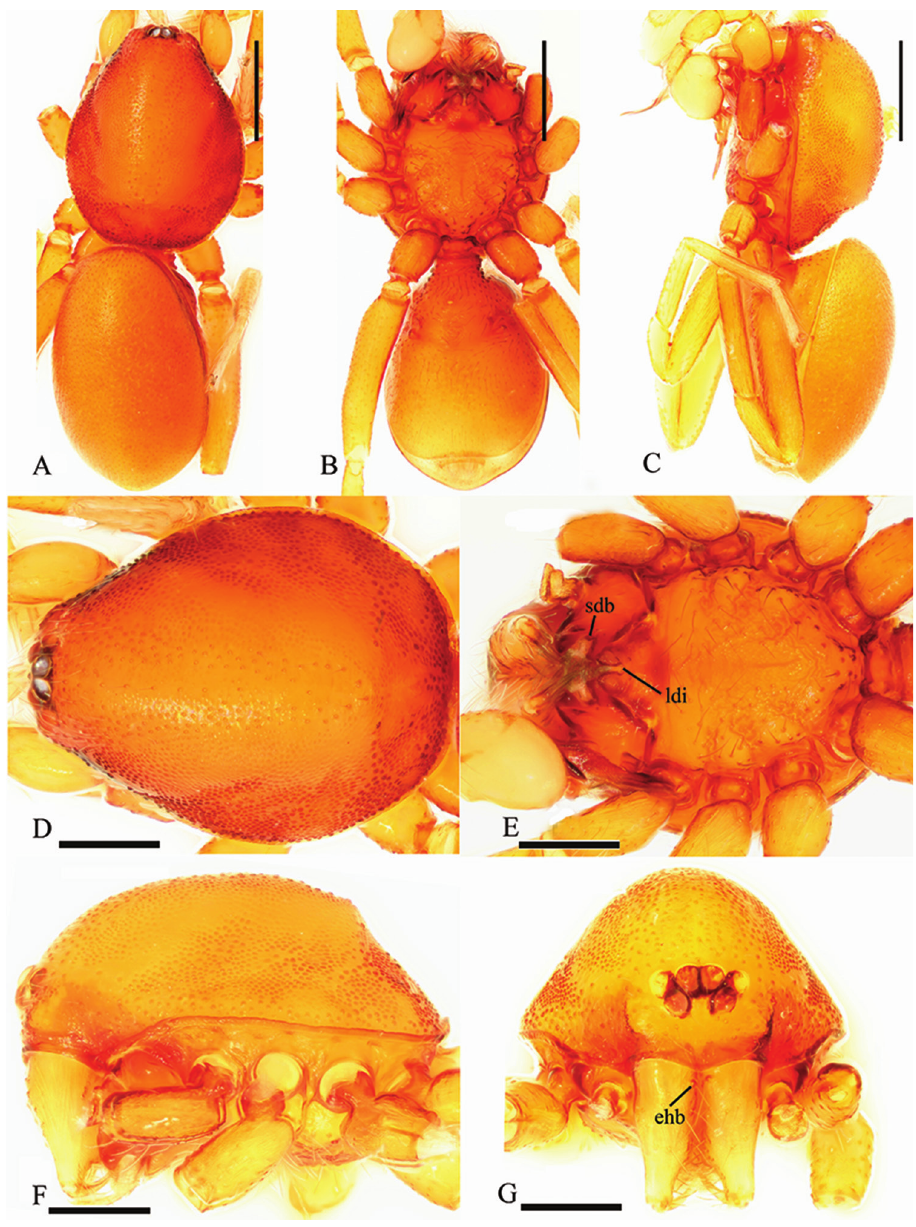
Figure 1. Trilacuna simianshan sp. n., male. A habitus, dorsal view B habitus, ventral view C habitus, lateral view D prosoma, dorsal view E prosoma, ventral view F prosoma, lateral view G prosoma, anterior view. Abbreviations: ehb = elevated hair base; ldi = labium deep incision; sdb = slightly distal branch. Scale bars: 0.2 mm ( A–C ); 0.1 mm ( D–G